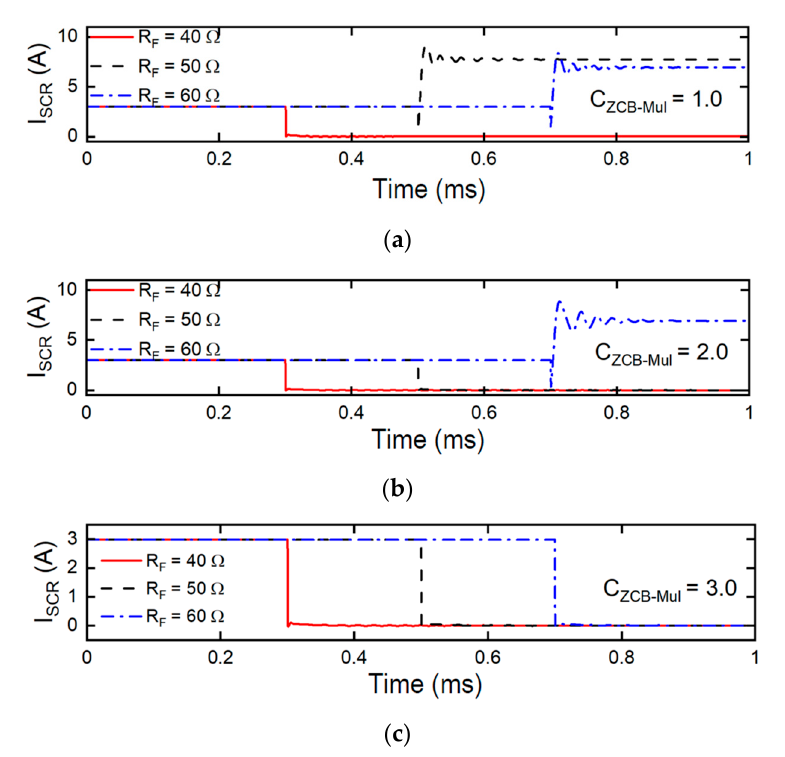
Figure 5. Three simulation tests to verify (1) with C ZCB-Mul = 1.0, 2.0, and 3.0 times. ( a ) SCR currents under the condition of C ZCB-Mul = 1.0. ( b ) SCR currents under the condition of C ZCB-Mul = 2.0. ( c ) SCR currents under the condition of C ZCB-Mul = 3.0.